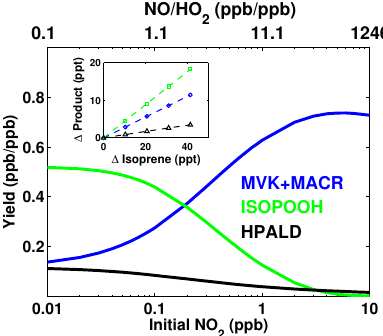
Figure 3. Theoretical yields of first-generation isoprene oxidation products for a series of isoprene oxidation experiments with vary- ing levels of NO x (Sect. 3.1). Yields are calculated as the slope of product formed vs. isoprene lost over minutes 10–15 of oxidation (example shown in inset). The upper axis shows average NO / HO 2 ratios over the same